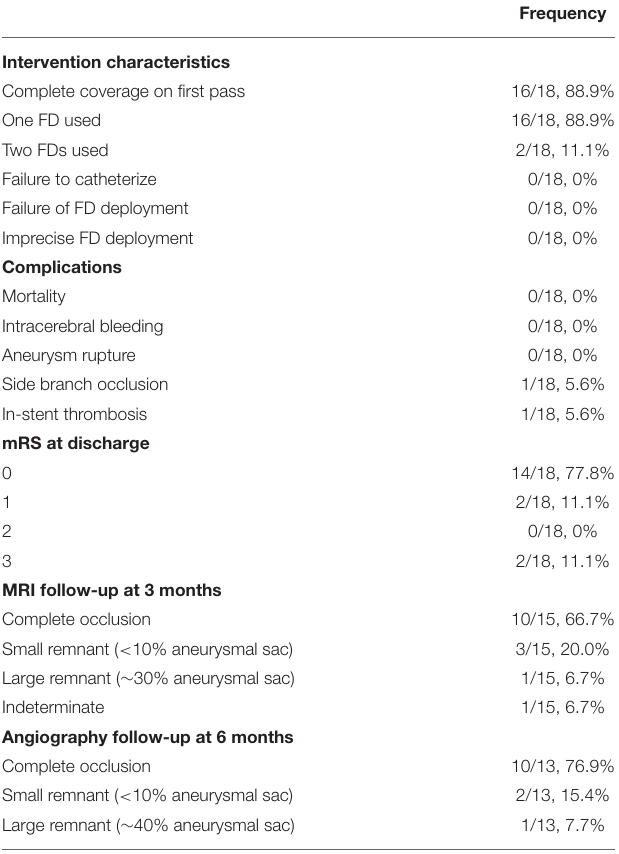
TABLE 2 | Intervention characteristics, outcomes, and follow-up.